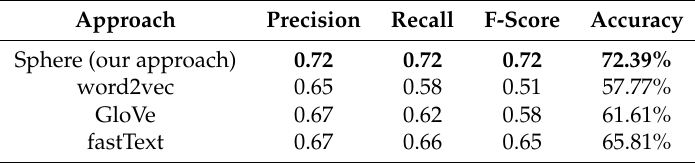
Table 6. Antonym/synonym discrimination results—nouns.